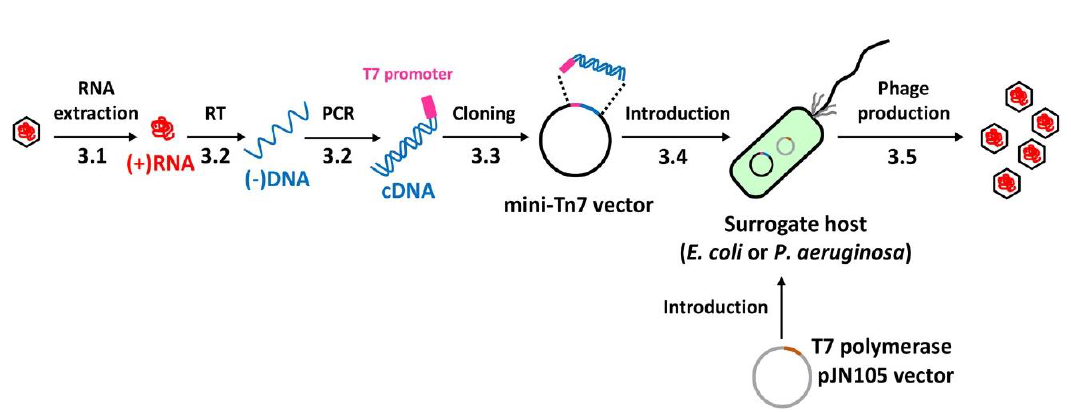
Figure 1. Experimental design for each stage of the protocol. The entire procedure from the phage RNA to the phage production is schematically represented. The numbers (3.1 to 3.5) designate the methods described in the text. The single-stranded DNA synthesized from the genomic RNA has been designated as (-)DNA, whereas the double-stranded DNA containing the sense strand is designated as cDNA in the entire text. The cDNA cloned into a mini-Tn 7 -based vector is introduced into either E. coli or P. aeruginosa , which express T7 polymerase. RT represents reverse transcription Once the cDNA fragments are obtained, they need to be cloned for isolation or separation of single cDNA molecule, because the cDNA sequences are deemed varied due to the high mutation rate of the phage RP [10]. Besides, it is also important to select appropriate vectors, given that the